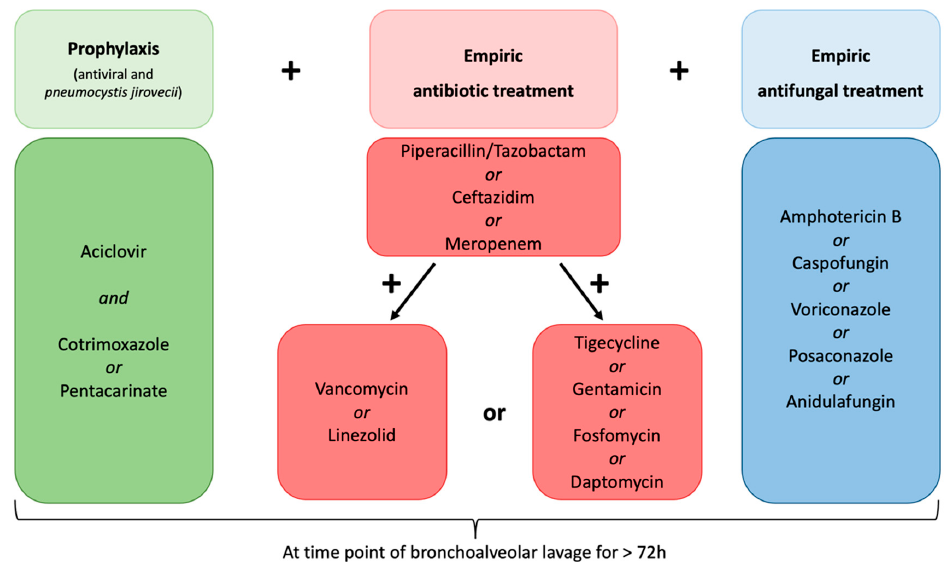
Figure 2. Hospital-based anti-infective treatment at time point of flexible bronchoscopy with bron- choalveolar lavage in each patient. All patients included in this study received empiric antibiotic and antifungal treatment for at least 72 h prior to bronchoscopy. The choice of empiric gram-positive targeted therapy and/or application of last-resort antibiotics and the choice of which antifungal agent was administered was at the discretion of the physician.